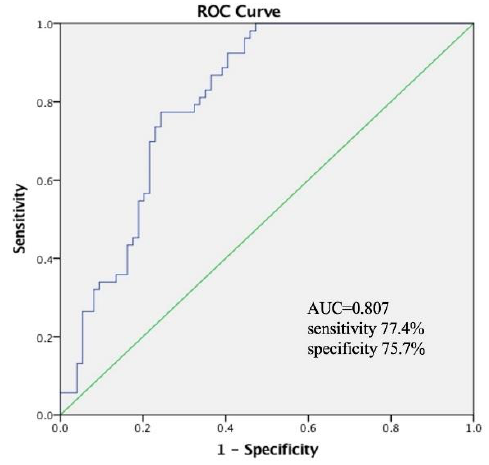
Figure 2. Receiver-operating curve analysis for phase angle (PhA) to diagnose malnutrition in males according to the GLIM criteria with optimal PhA level cut-off of 6.11°.